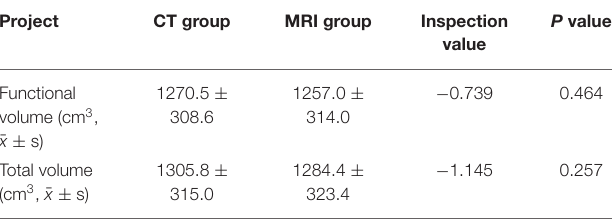
TABLE 1 | Liver volume measured by CT and MRI reconstruction. Project